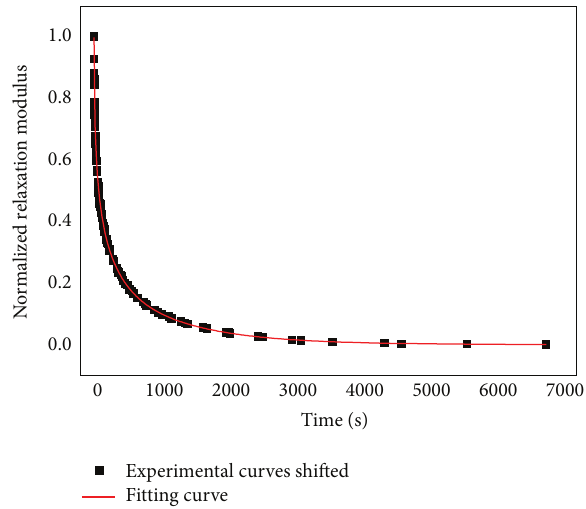
Figure 4: The master relaxation curve of PLGA and its fitting curve at 65 ∘